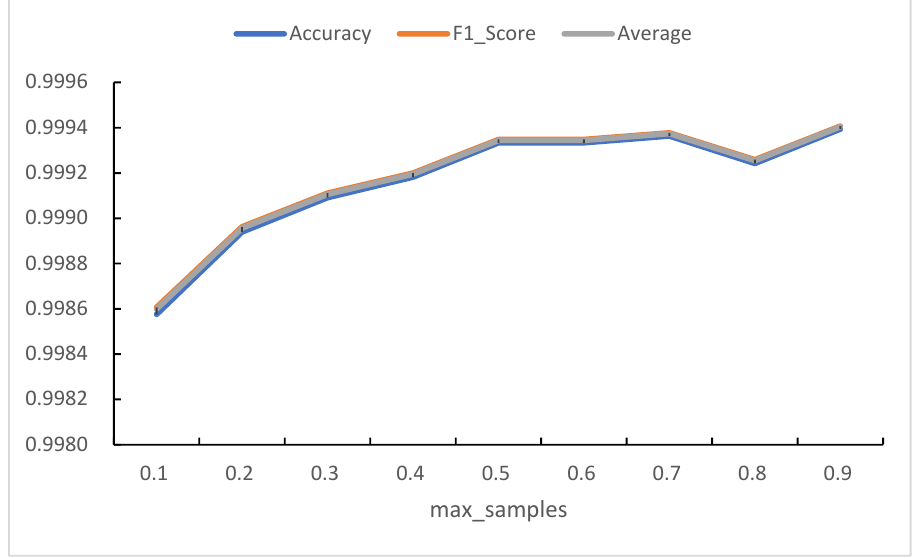
Figure 13. max_samples optimizes Accuracy, F1_Score, and Average.